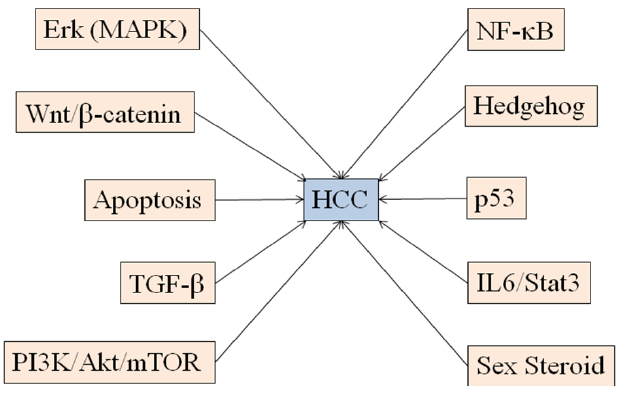
Figure 1. Signaling pathways affected by Hepatitis C virus (HCV) proteins. ( a ) Signaling pathways involved in hepatocarcinogenesis. ( b ) Signaling pathways affected by HCV core protein. ( c ) Signaling pathways affected by HCV NS5A